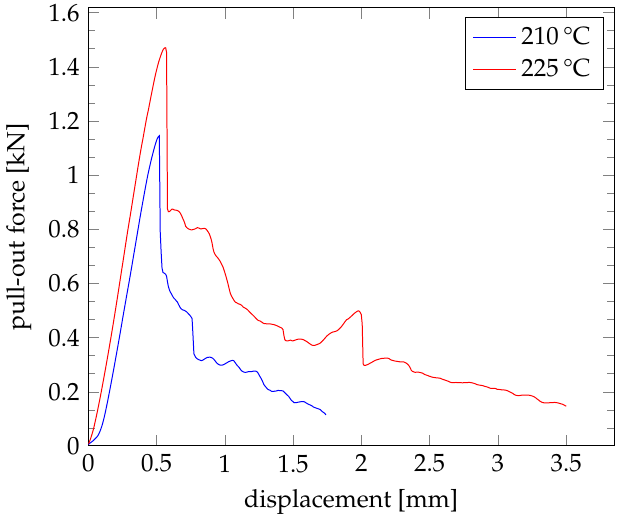
Figure 15. Characteristic force-displacement graphs of the pull-out tests for variations of the temper- ature.